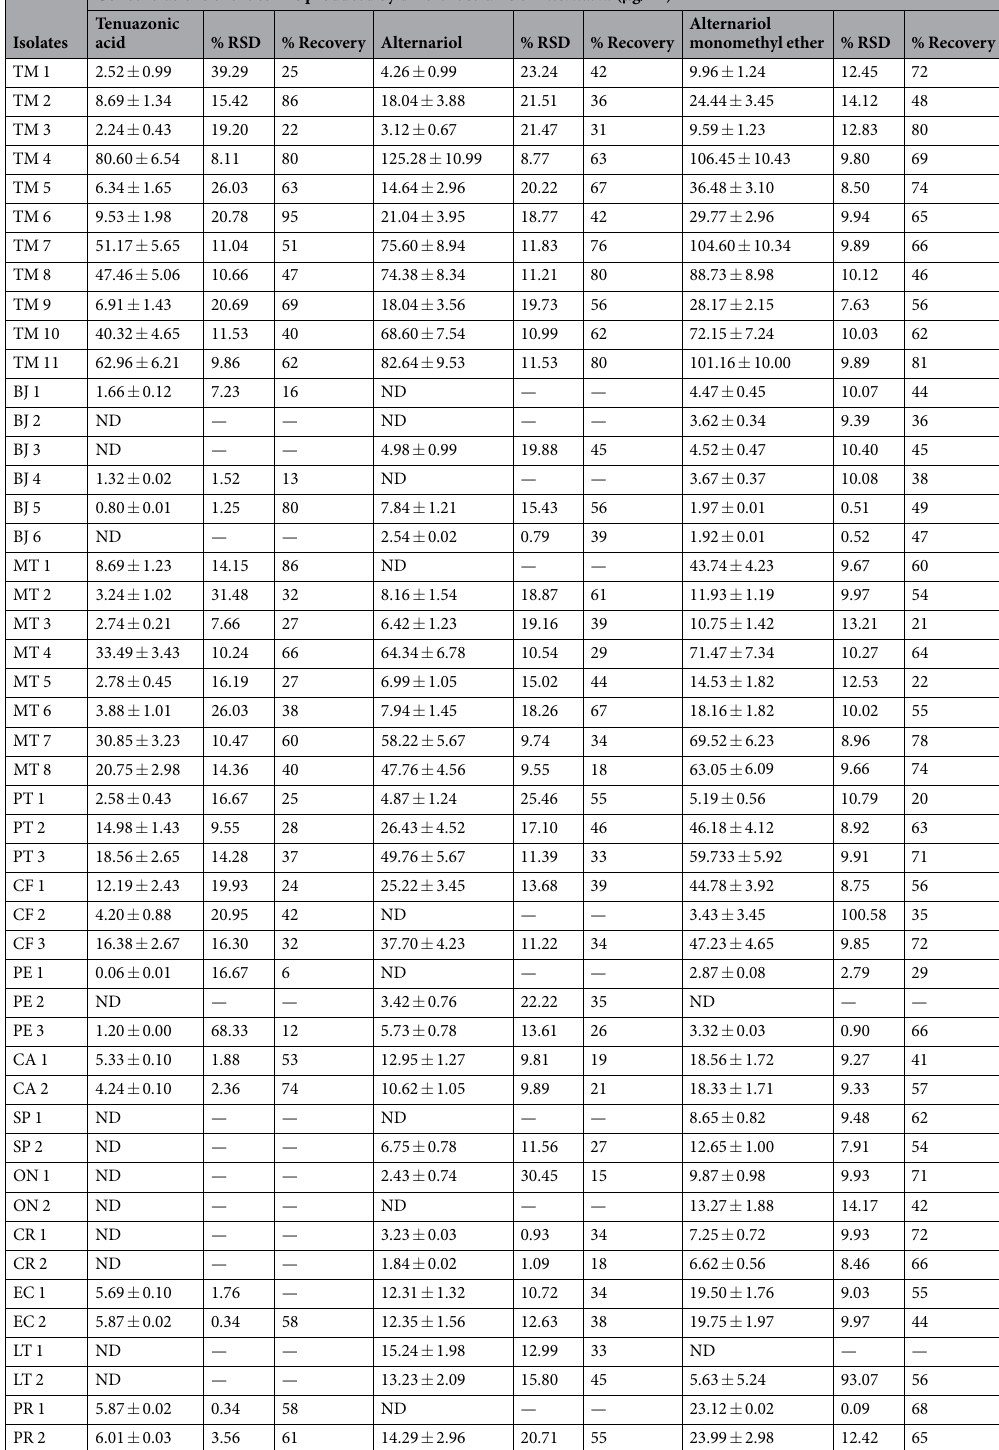
Table 4. Table showed the concentrations of three different toxins tenuazonic acid (TeA), alternariol (AOH), and alternariol monomethyl ether (AME) from Alternaria isolates Note: ND - Not detected. Mean values ± standard deviation of all the experiments consisting of three replicates